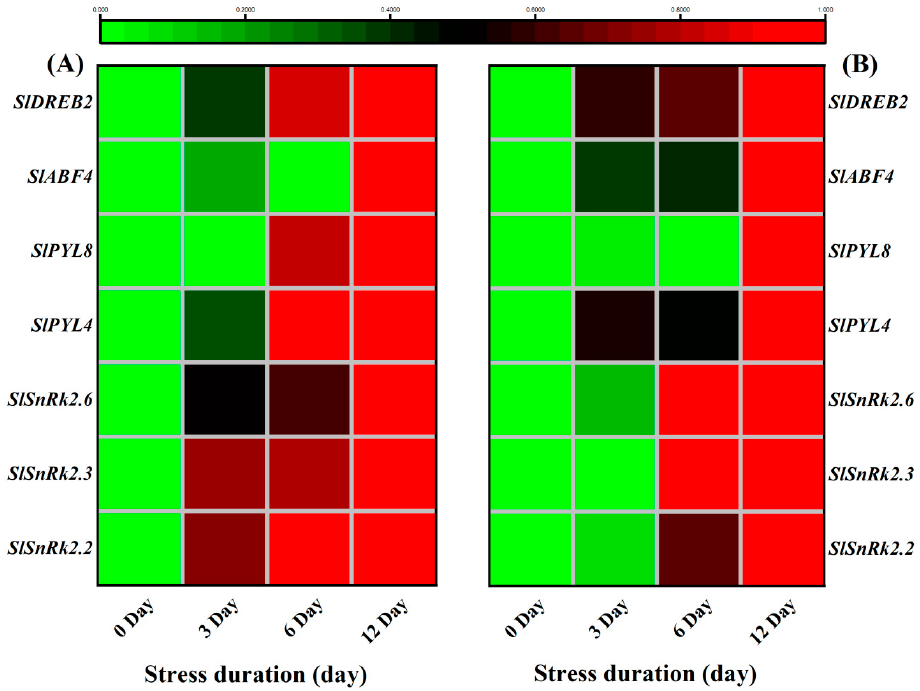
Figure 12. Heatmap of selected genes related to ABA signalling pathway. The relative expression level was quantified from tomato ( A ) Leaves and ( B ) roots after 12 days of salt treatment. The scale (Log 2 of the mean values after normalization; n = 3) shows the increase in relative concentrations from green to red color, compared to control (0 h).